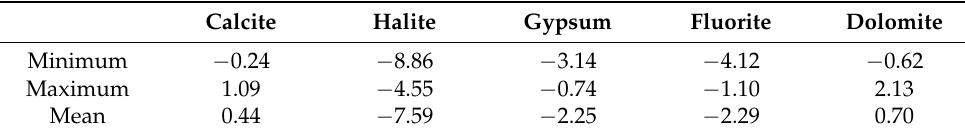
Table 2. Calculated SI values for selected